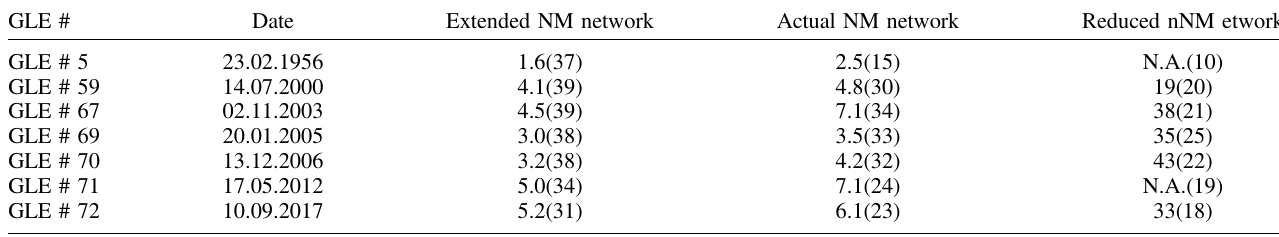
Table 2. The value of the merit function D obtained for the analysis of several GLEs (main phase of the event) as a function of the number of the used NM stations. Columns 1 – 2 correspond to the number and date of the GLE, while columns 3 – 5 correspond to D and number of the used stations (in the brackets) for extended NM network, actual NM network used for the analysis and the reduced NM network, respectively. N.A. depicts the case when the SEP spectra cannot be unfolded. The details for the analysis of the presentedGLEs are given in Mishev et al. (2014),